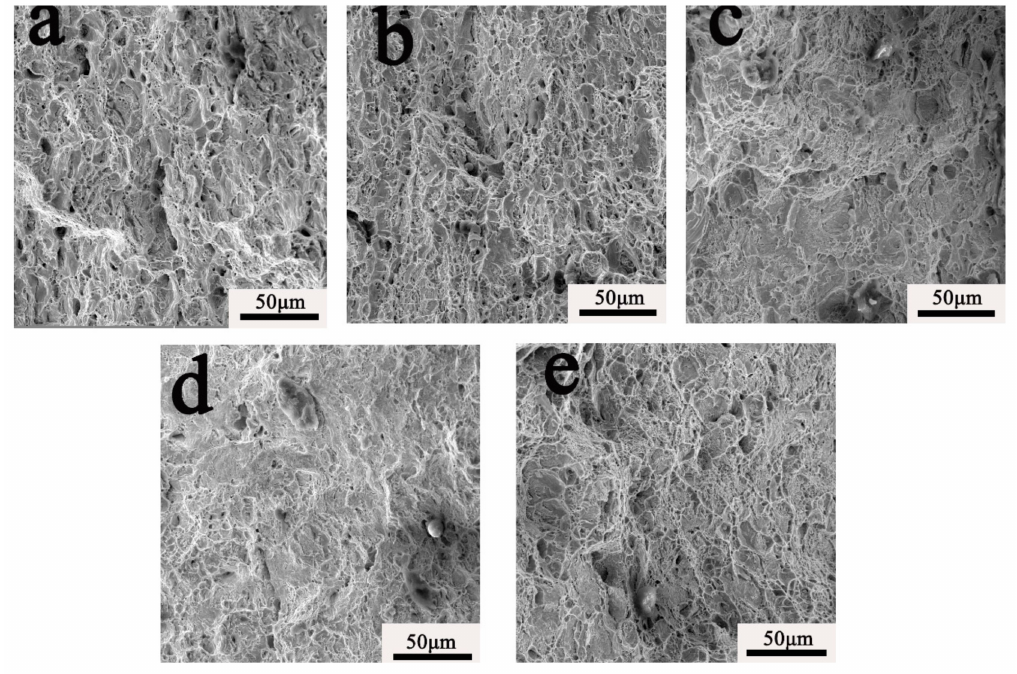
Figure 12. Fracture surfaces of the untreated samples: ( a ) A1, ( b ) A2, ( c ) A3, ( d ) A4, and ( e )